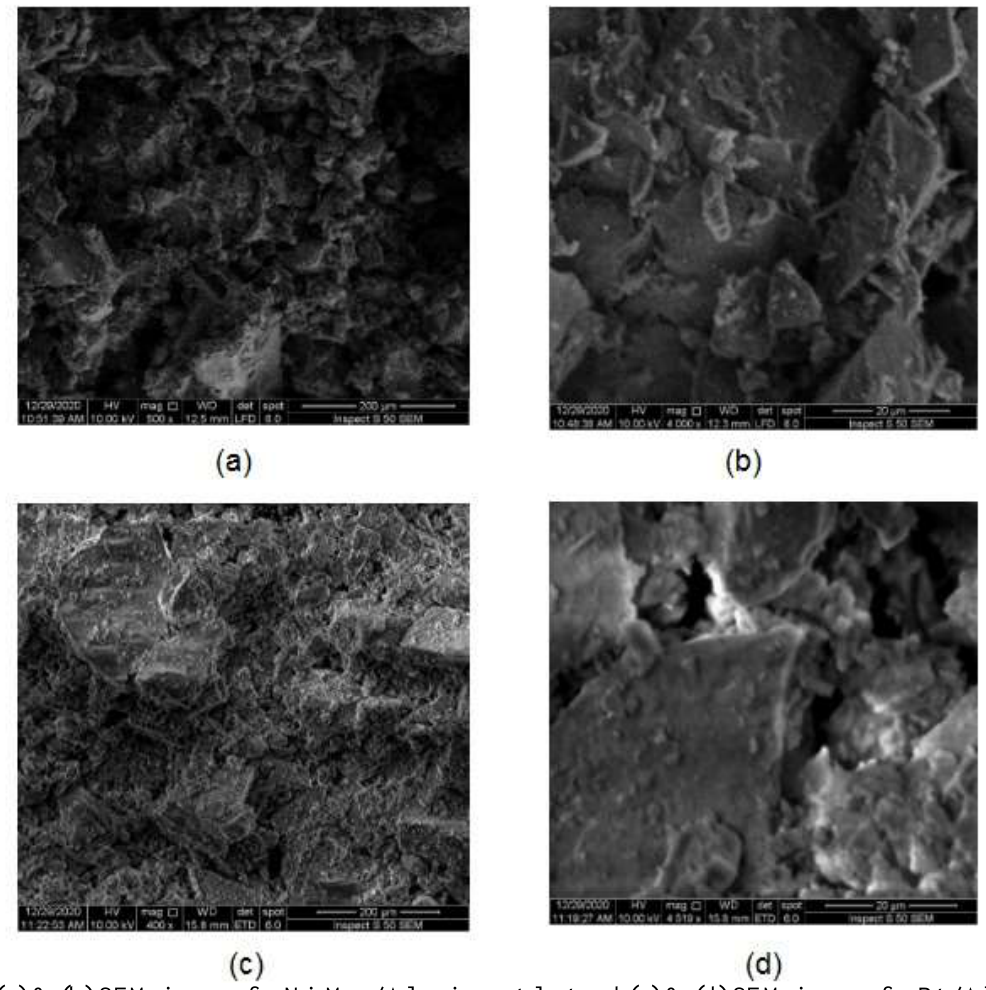
Figure 5: (a) & (b) SEM images for Ni, Mo / Alumina catalyst and (c) & (d) SEM images for Pt / Alumina